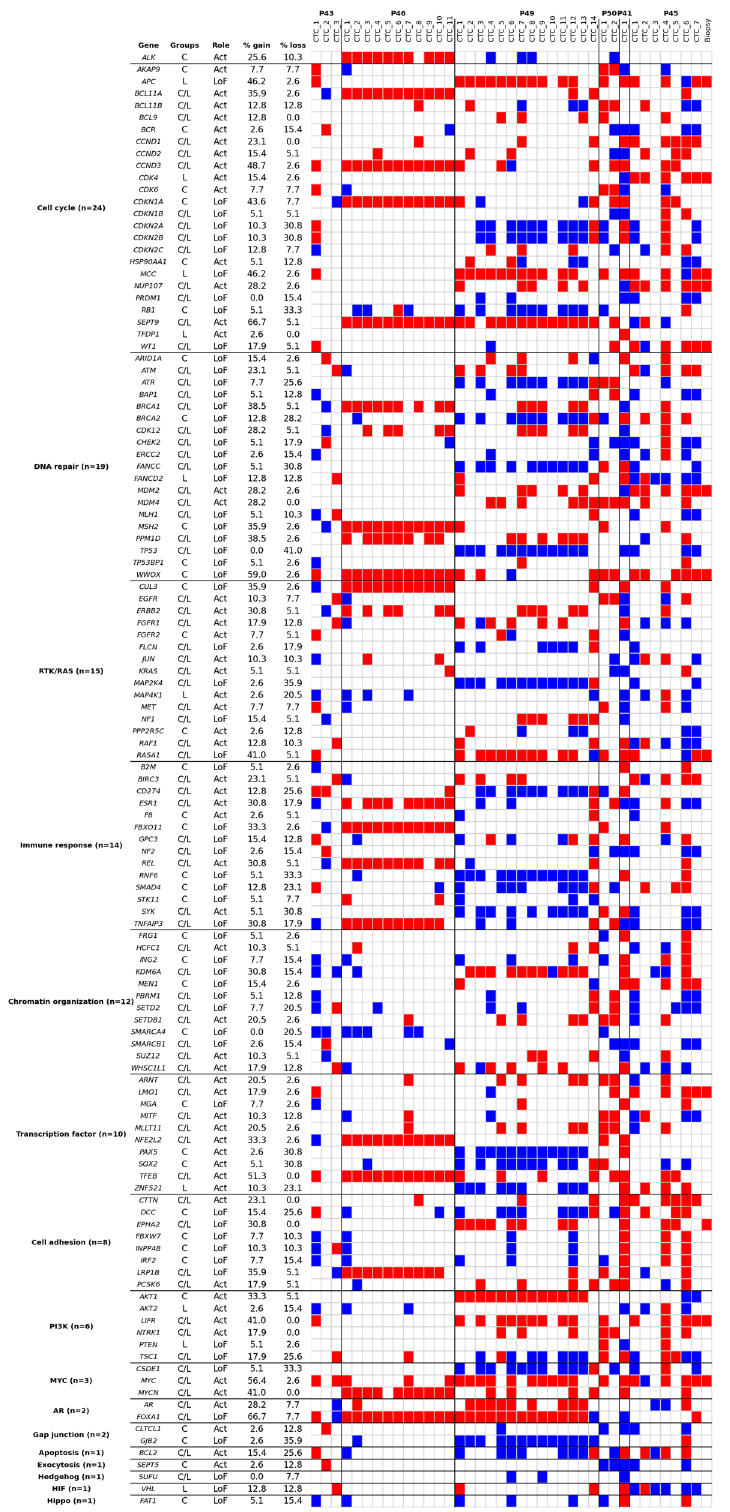
Fig. 4 Heatmap of CNA oncogenic drivers in CTC samples. The altered genes are attributed to pathways. The pathways are sorted from the most to the least altered. The number of altered genes per pathway is shown in parentheses. CNA drivers present in patients at resistance to crizotinib only, in patients at resistance to lorlatinib only, and in both, are annotated “ C ” , “ L ” and “ C/L ” respectively in the “ Groups ” column. CNA driver function (activating or loss of function) is mentioned in the “ Role ” column. Frequencies of gain and loss in the 39 samples (38 CTC samples and 1 biopsy) are provided. Red and blue colors represent gains and loss